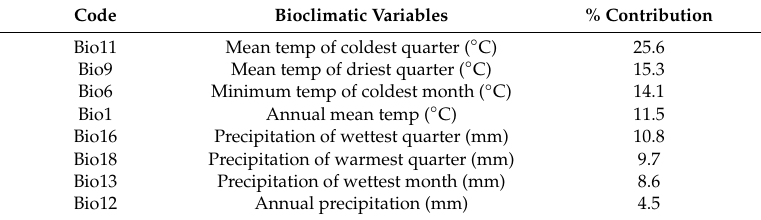
Table 2. Contribution of each of 8 selected variables in MaxEnt for D. armandi .